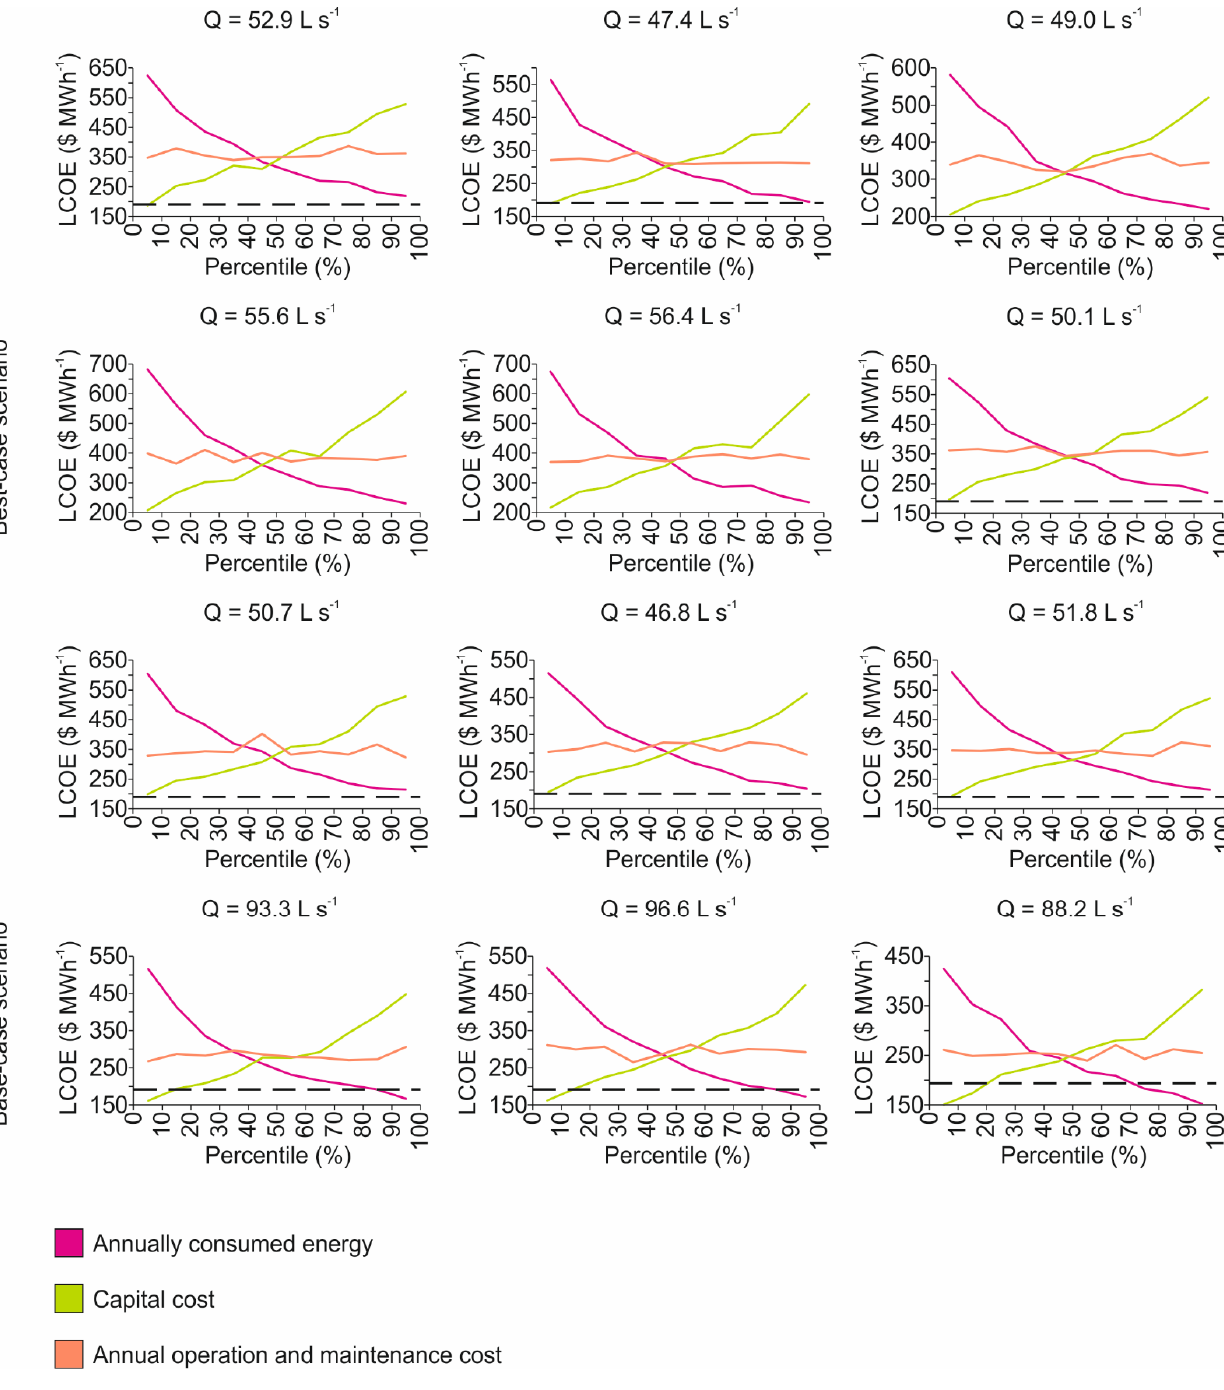
Figure 19. Levelized cost of energy as a function of the uncertain parameters’ percentile for configuration A. Dashed line—heating energy cost with oil furnaces (see text for further details). The reader is referred to Tables 4 and 5 for further details on the flow rates.